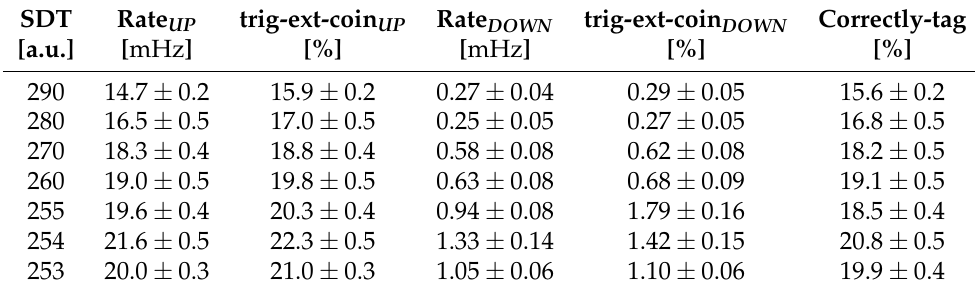
Table 2. Measured rate of correctly-tagged events (rate UP ) [fake events, (rate DOWN )] and corresponding amounts of external trigger with an event measured by Cherenkov prototype also (trig-ext-coin). Last column shows the net percentage of external triggers which correspond to correctly-tagged events, with a charge threshold equal to 60 a.u.